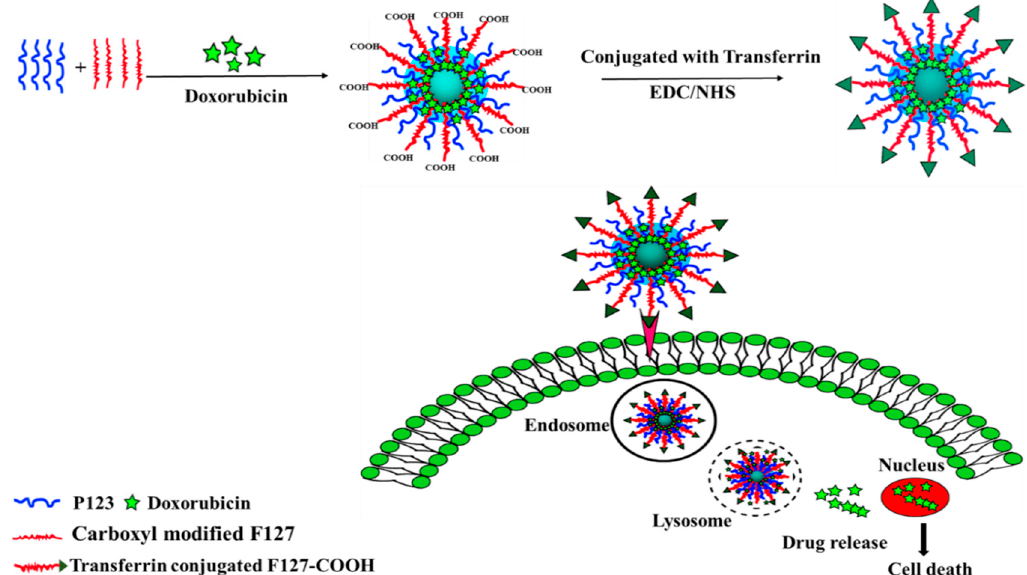
Figure 1. Schematic illustration of the preparation of transferrin-conjugated polymeric nanoparticle for receptor-mediated delivery of Dox in Dox-resistant breast cancer cells.